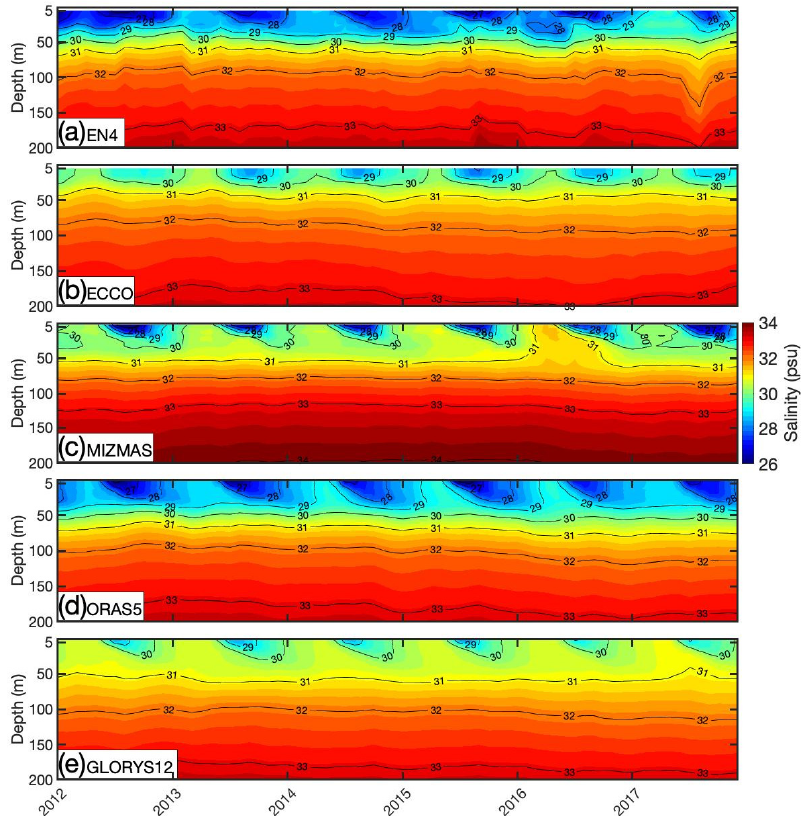
Figure 8. Contours of salinity (psu) averaged along 150°W between 70.5°N and 80.5°N, as a function of depth and time from 2012–2017 for ( a ) EN4 ( b ) ECCO, ( c ) MIZMAS, ( d ) ORAS5, and ( e ) GLO- RYS12.